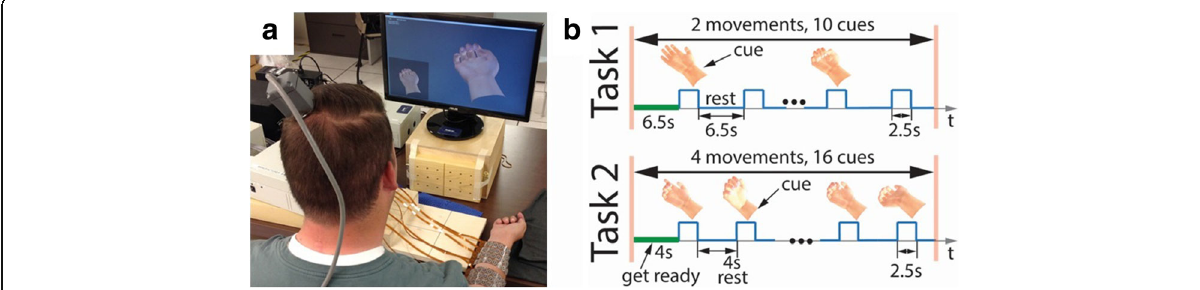
Fig. 1 a System setup. The participant was seated in front of a computer monitor, where imaginary movements provided to him via a virtual hand at rest condition at the lower left corner on the screen. b Experimental timeline for a single block. Here, it shows a block for Task 1 and 2, respectively. In Task1, there was only two hand movements, hand opening and hand closing. While in Task2 there were four cued hand movements within each block. In between the blocks within each task, there was usually a 2 – 3 min